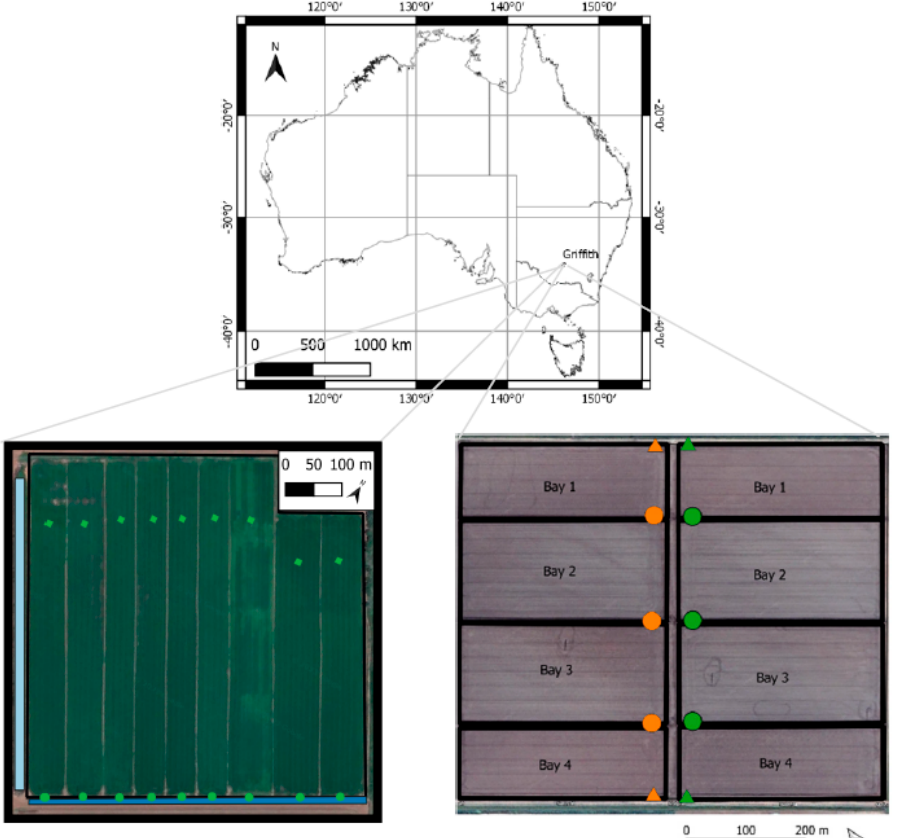
Figure 3. Both field sites were located near Griffith in the NSW Riverina. Site A ( left ) was a nine- bay border check field. Site B ( right ) was two bankless channel fields, each with four bays, with automation installed in the easterly field. Dots identify rubber lay-flat outlets, whilst triangles depict undershot sluice gates and diamonds resemble IoT communication structures. Automated irrigation infrastructure is indicated in green color, whilst manual infrastructure is indicated in orange. Blue is used to show the supply channel and storage dam at Site A. At Site B, Bay 1 was connected to the supply channel and drainage was carried out via Bay 4 outlet.